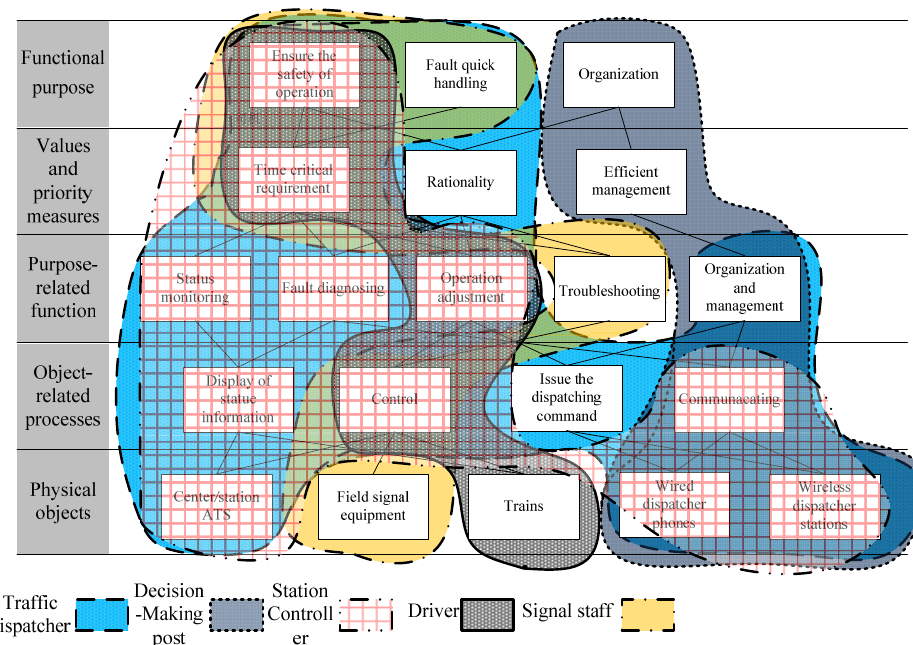
Figure 3. Abstract-level model for the traffic dispatching team.